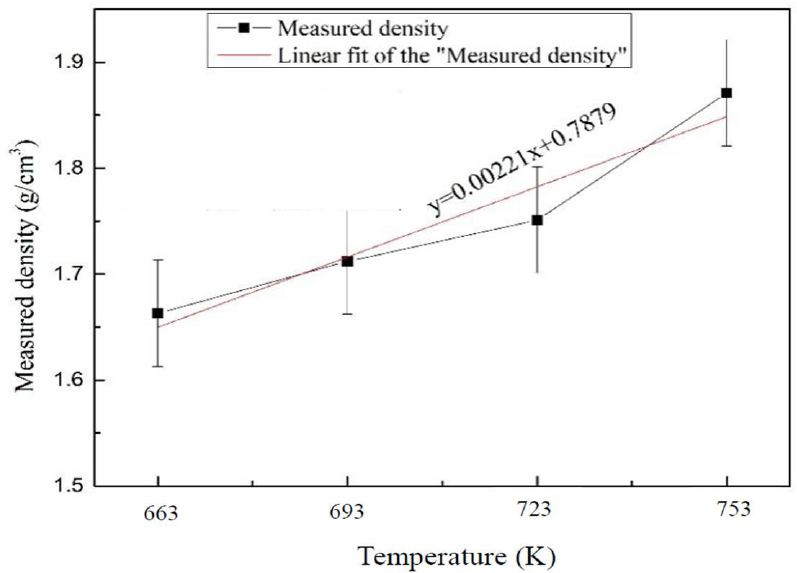
Figure 8. Density of the Al 2 O 3hs /AZ91D syntactic foams.